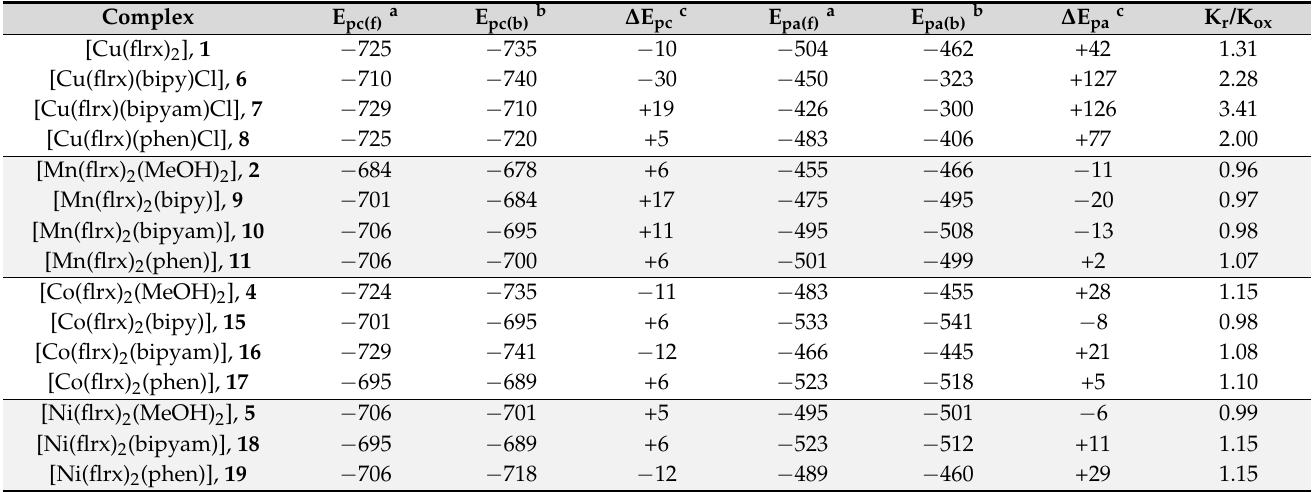
Table 7. Cathodic and anodic potentials (in mV) for the redox couple M(II)/M(I) of the fleroxacin complexes in a 1:2 DMSO/buffer solution in the absence or presence of CT DNA. Ratio of equilibrium binding constants, K r /K ox